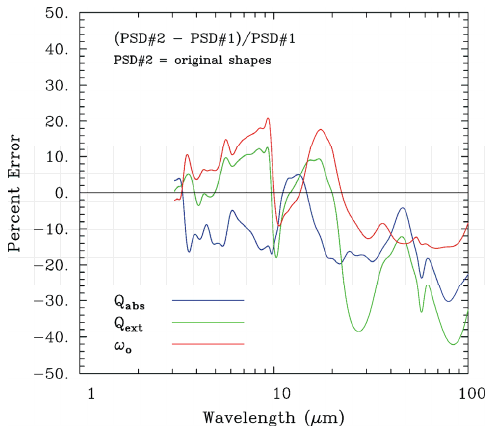
Figure 8. Wavelength dependence of optical property errors for PSD #2 in Fig. 4 (green curve), Fig. 8. Wavelength dependence of optical property errors for PSD relative to the measured PSD (PSD #1). Ice particle shape attributes are roughly the same in #2 in Fig. 4 (green curve), relative to the measured PSD (PSD #1). these two PSD. Ice particle shape attributes are roughly the same in these two